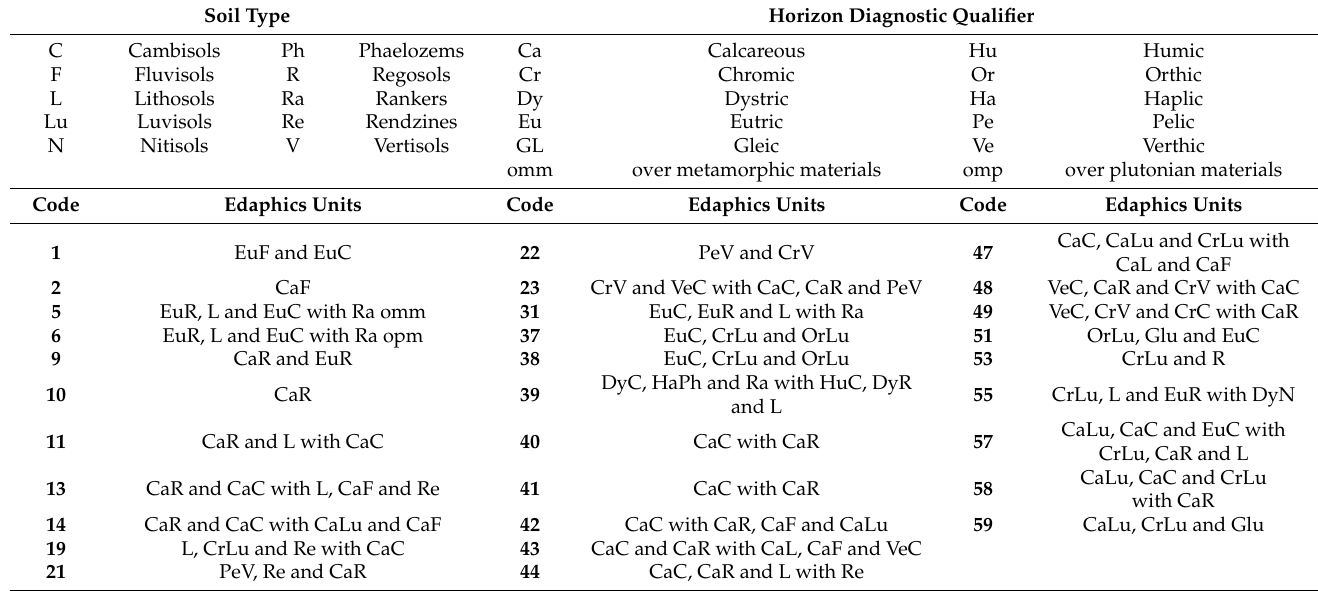
Table 1. Edaphic soils unit of the study area, (legend table first